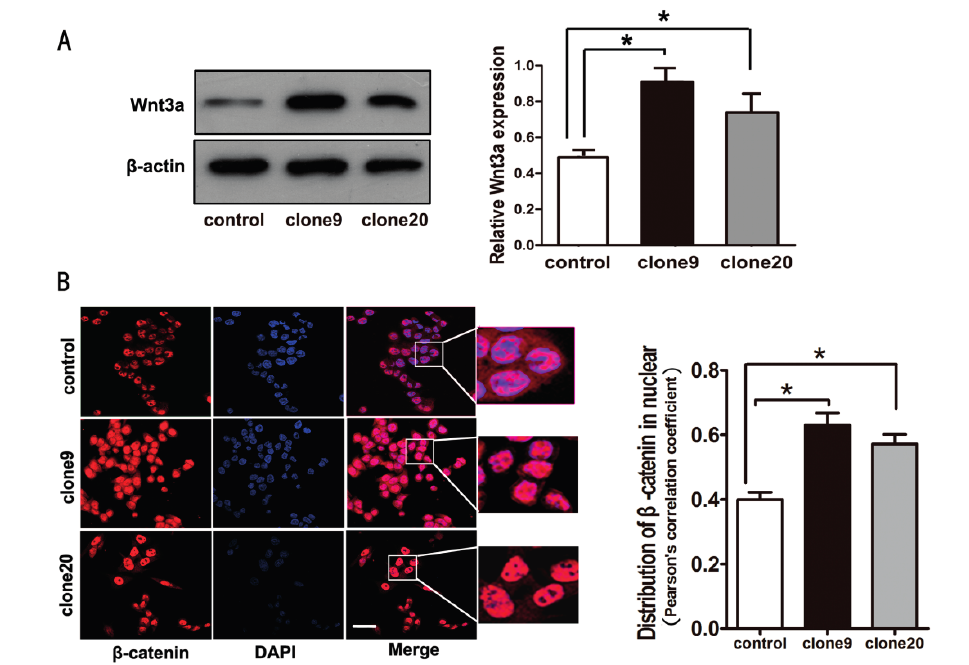
Figure 3. Wnt3a overexpression-induced activation of Wnt/ β -catenin signaling in HT29 cells. ( A ) Wnt3a protein expression levels were significantly increased in clone9 and clone20, and HT29 cell pools transfected with Wnt3a plasmid ( left ). Relative amount of protein expression of Wnt3a/ β -actin ( right ) ( * p < 0.05); ( B ) Increased β -catenin accumulation in the nucleus was observed in cells overexpressing Wnt3a compared to control cells (immunofluorescent staining) ( left ). Scale bar: 50 μ m. Red signal